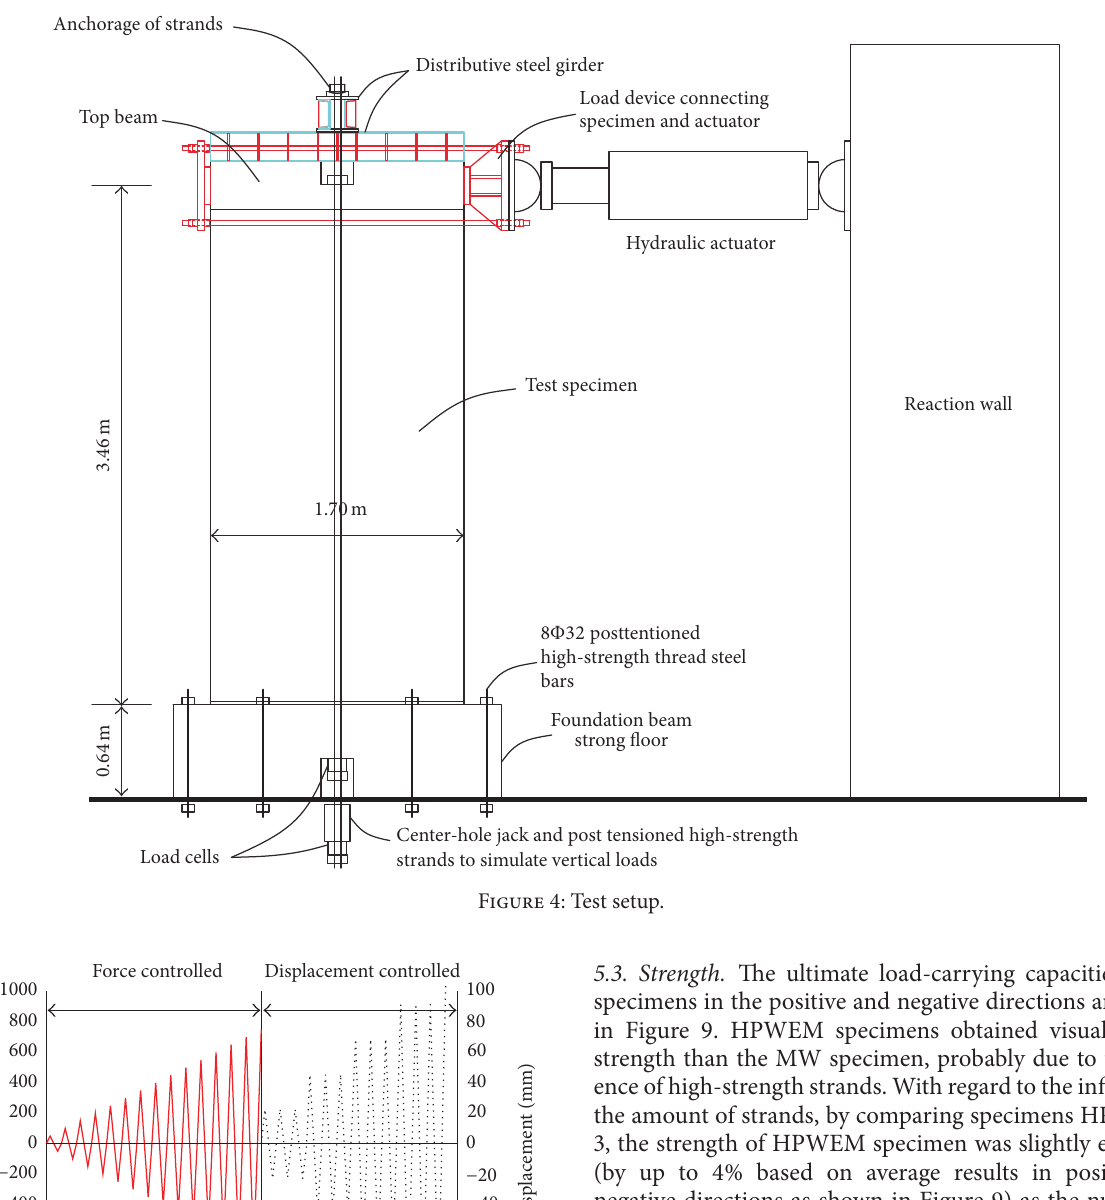
Besides, the predicted 𝑉 𝑏 - Δ 𝑤 relationship curves in posi- tive direction for the specimens using ABAQUS models are also appended in Figure 8. The analytical results provided a reasonable match to the envelope of the measured 𝑉 𝑏 - Δ 𝑤 curves of the specimens. The measured and analyzed peak loads were annotated in Figure 8, and the deviations between them were controlled by ± 6% at